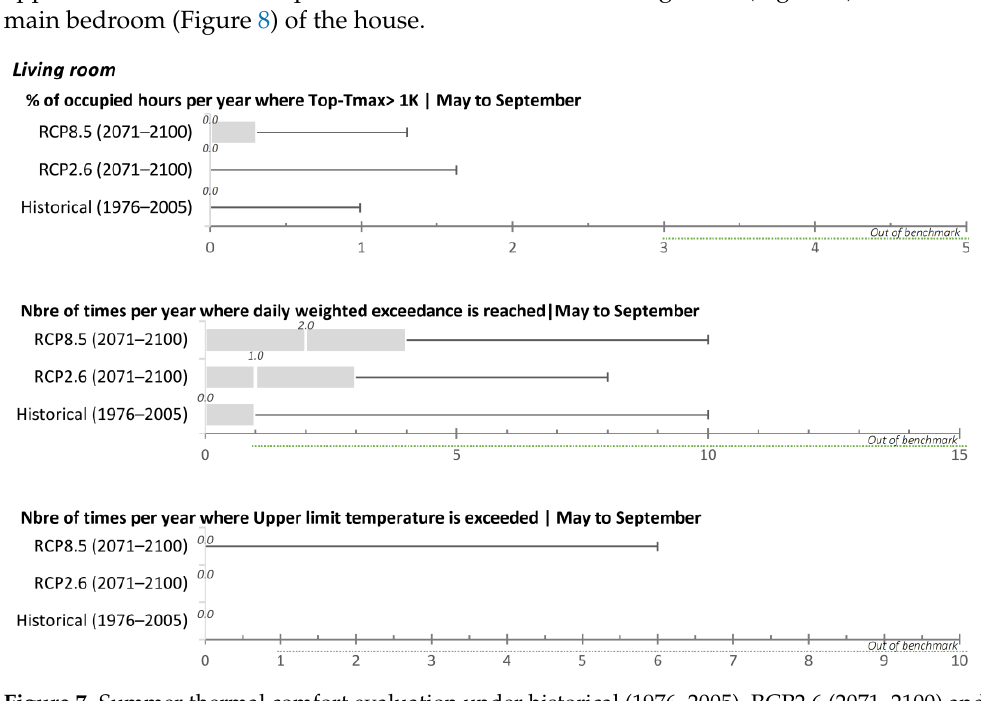
Figure 7. Summer thermal comfort evaluation under historical (1976 – 2005), RCP2.6 (2071 – 2100) and RCP8.5 (2071 – 2100) scenarios resulting from the application of the criteria presented in Table 3 for the living room.